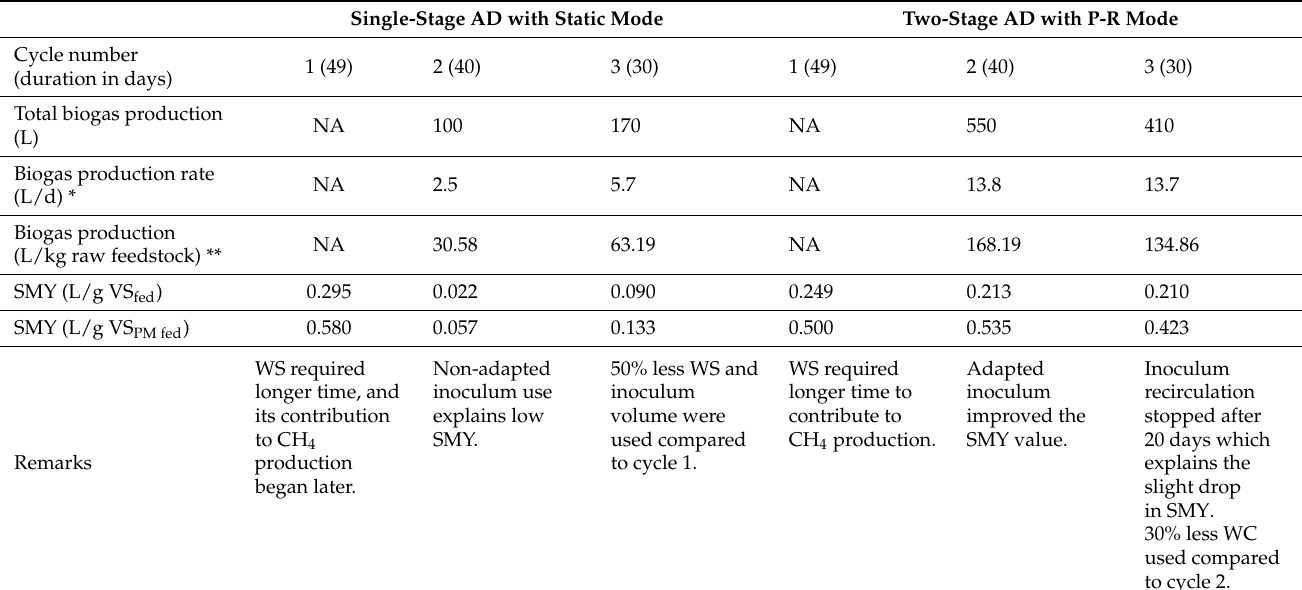
Table 4. Specific methane yield values for each cycle and both modes of operation. Single-Stage AD with Static Mode Two-Stage AD with P-R